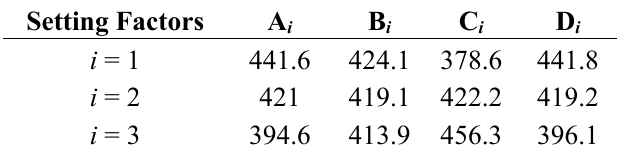
Table 11. Average torque for all levels of all factors.